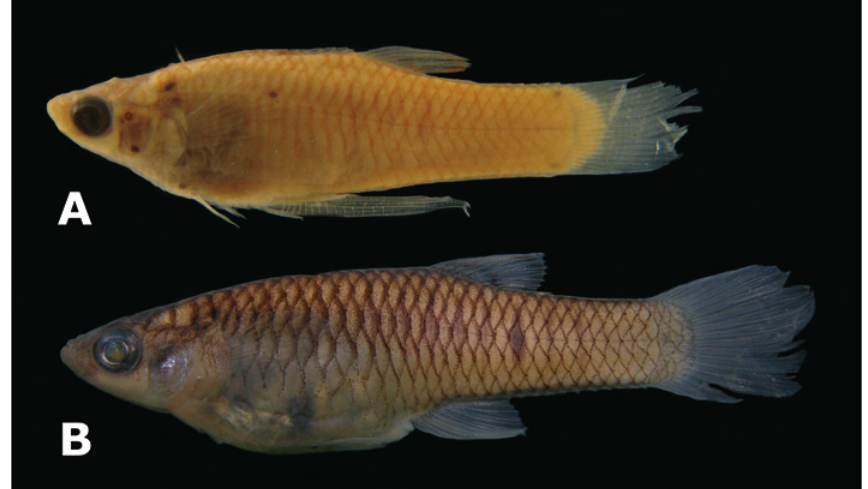
Fig. 23. Phalloceros enneaktinos . (A) Holotype, male, 24.2 mm SL, MNRJ 23609, córrego da Toca do Boi, near Condomínio Laranjeiras, Parati, Rio de Janeiro, Brazil; (B) paratype, female, MCP 31139, 30.7 mm SL, collected with the Description . Morphometric data in Tables 9 and 10. Range of SL: 23.5 to 35.8 mm (females), 19.4 to 24.2 mm (males). Dorsal- fin rays: 9* [16]. Branched pectoral-fin rays: 6 [2], 7* [8]. Pel-